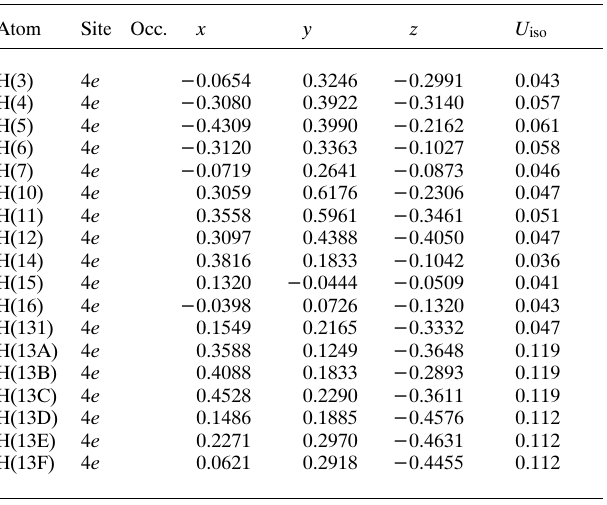
Table 2. Atomic coordinates and displacement parameters (in Å 2 )